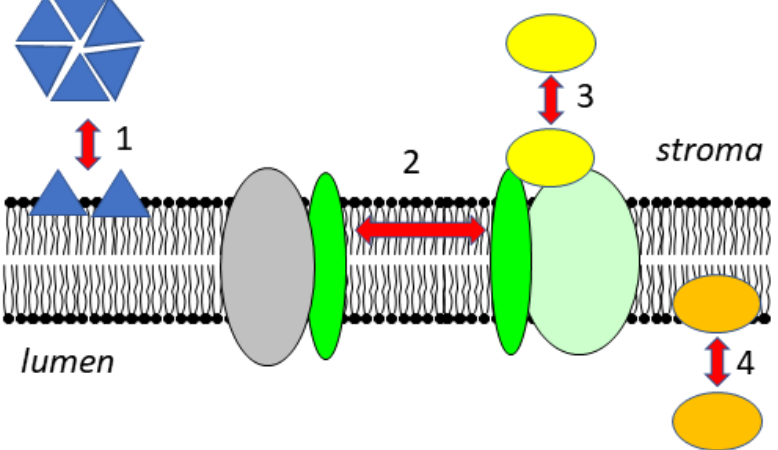
Figure 1. Dynamic changes of the association of proteins with the thylakoid membrane. In the stroma, proteins can be present in soluble forms or as peripheral membrane proteins, and their oligomerization state can change upon membrane association ( 1 ). Transmembrane proteins can move laterally within the membrane and are associated with different partner proteins ( 2 ). Soluble proteins can attach to protein complexes in the membrane ( 3 ). In the lumen, soluble proteins can attach to the membrane as a function of pH ( 4 ).